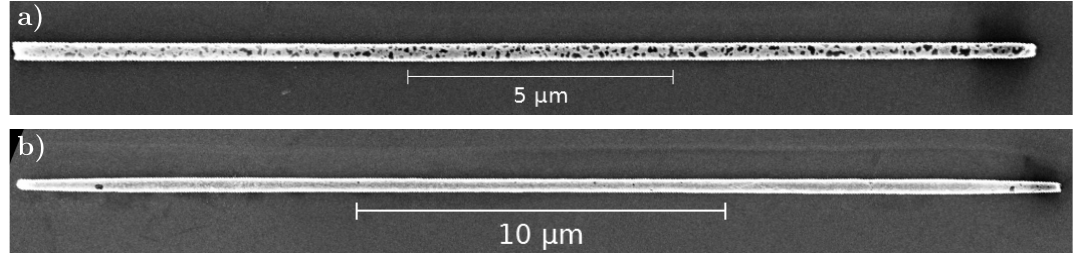
Fig. 11: Defects upon in-situ annealing (500 ◦ C ± 50 ◦ C). SEM images of two tubes lying on the same substrate, displaying a very different amount of defects after an- nealing. Both tubes displayed axial magnetization after annealing. The difference may come from a variation in the tube wall